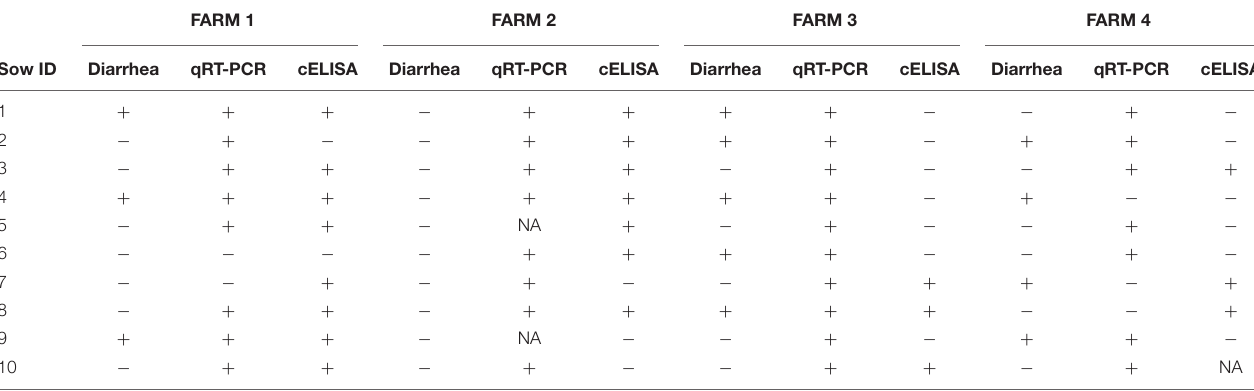
TABLE 4 | Diarrhea, PEDV detection in fecal samples, and cELISA results of sows. FARM 1 FARM 2 FARM 3 FARM 4 Sow ID Diarrhea qRT-PCR